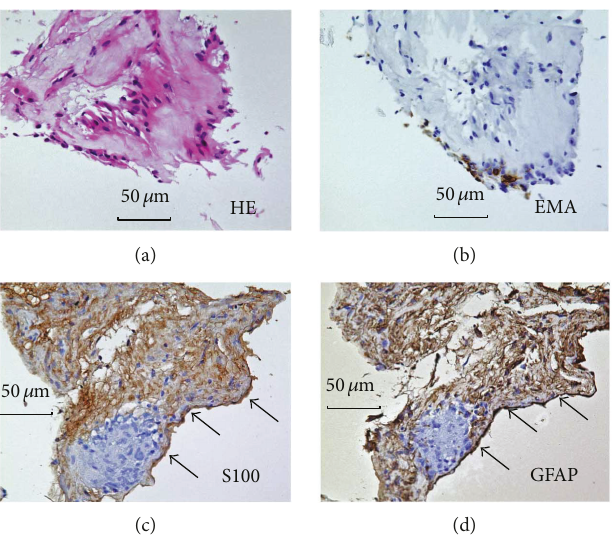
Figure 8: Histology (a) and immunohistochemistry (b – d) of a resected epipapillary membrane tissue in case 5. (a) Light micrograph showing marked hyalinization. Spindle-shaped stromal cells were intermingled in the section (hematoxylin-eosin). (b) Immunochemistry for cytokeratin. Immunoreactivity was not observed. (c) Immunoreactivity for S100 was strongly detected in the membrane (arrows). (d) Immunoreactivity for GFAP was strongly detected in the membrane